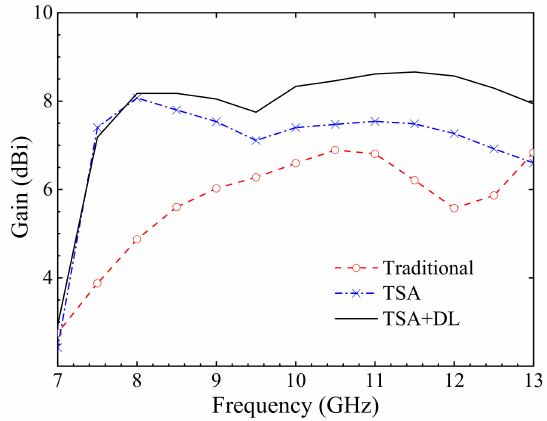
Figure 3. The gain of different structures of tapered slot